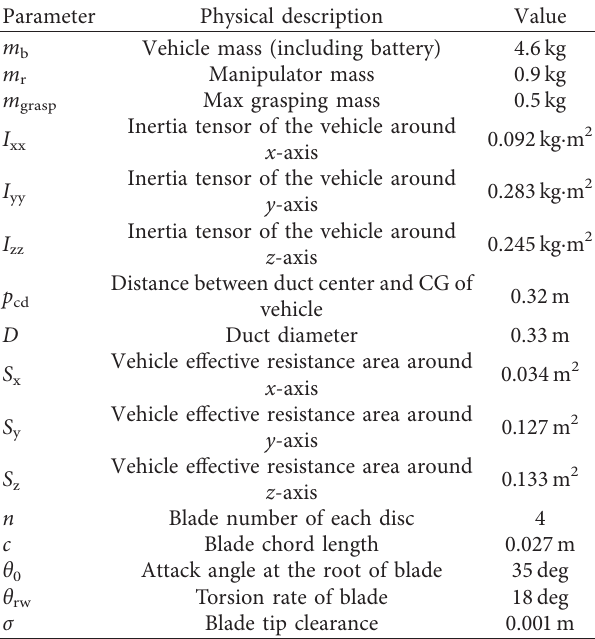
Table 1: Structural parameters of the